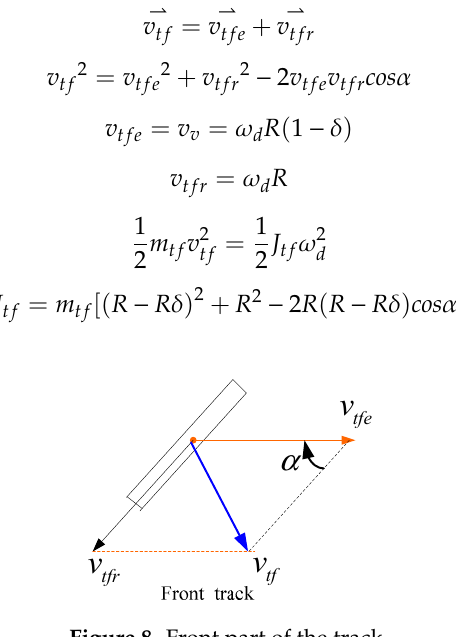
Figure 8. Front part of the track.